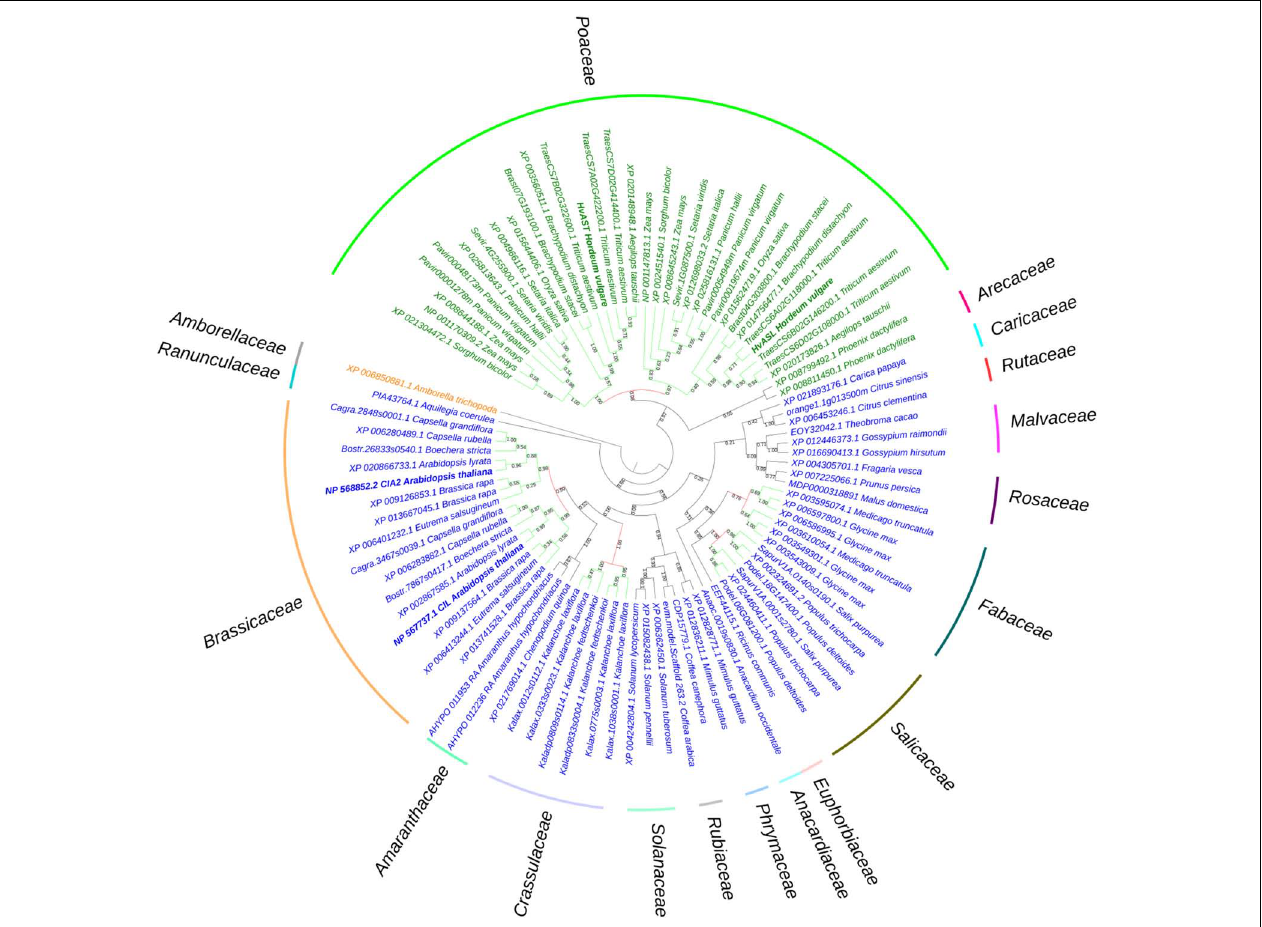
FIGURE 1 | Phylogenetic analysis of HvASL and HvAST homologous genes. The phylogenetic tree shows Amborella trichopoda as a sister group to all other angiosperm species. The two main branches separate the monocots and dicots, indicated by green and blue color, respectively. Evolutionary analysis reveals a single pair of paralogs in diploids, and two pairs of paralogs in tetraploids. The paralogs of each species divide into two branches; each branch contains the corresponding orthologs for species in families Poaceae , Salicaceae , Fabaceae , Crassulaceae, and Brassicaceae . Maintenance of these paralog pairs indicates that HvASL probably retained an important function in barley. The numbers above/below the branches represent bootstrap values which indicate reliability of the cluster descending from that node. The red color node indicates where splitting of the orthologous groups occurred. Positions of HvASL, HvAST, AtCIL, and AtCIA2 are highlighted in bold. Family information is indicated outside the colored